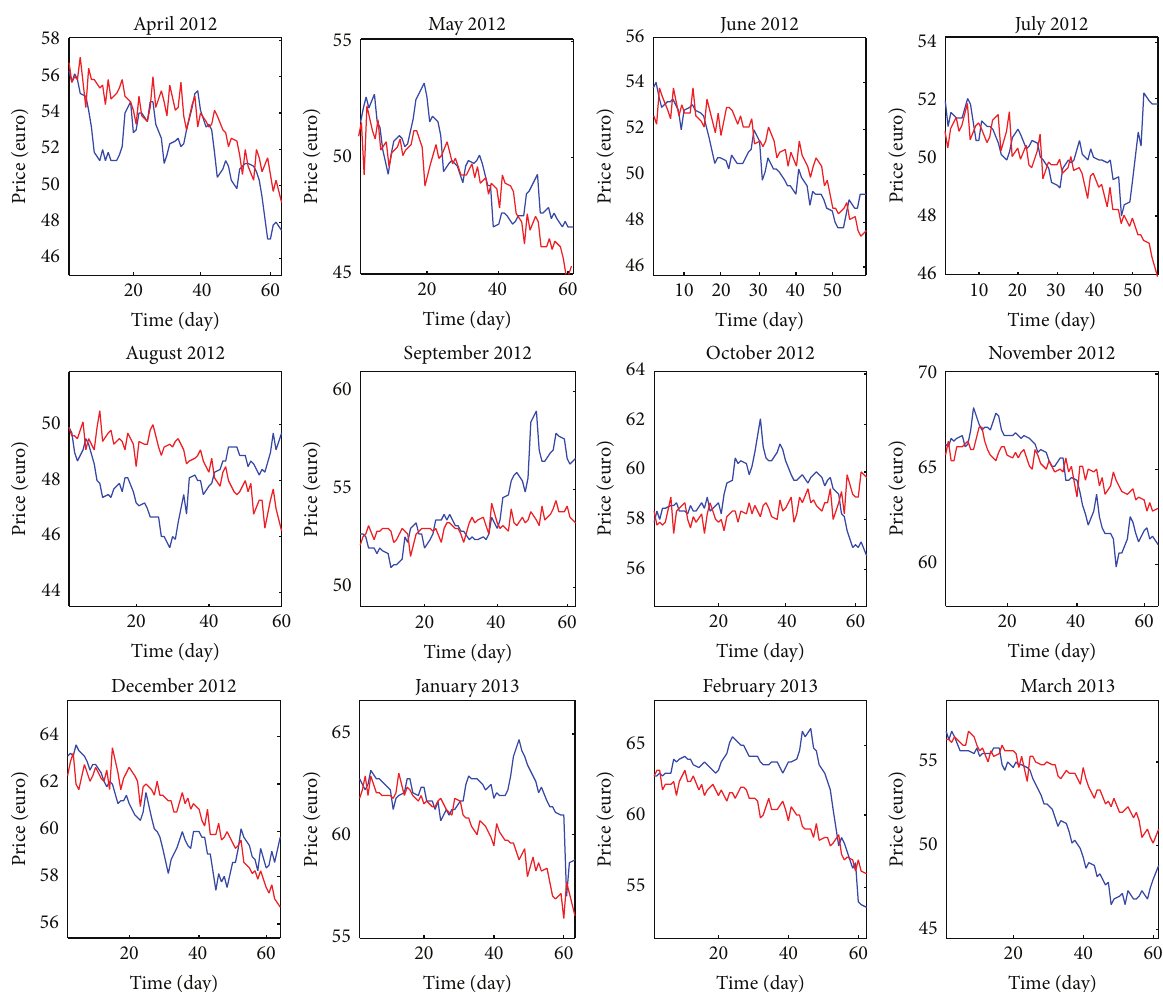
Figure 3: In this figure, we present the price curves obtained by simulating all the peak contracts using (71) with the specification above stated. Thegraphicsinthefigurepresentlong-termforecastsofthecontractsvalueandthemonthwrittenaboveeachgraphreferstoelectricitysupply of the contract